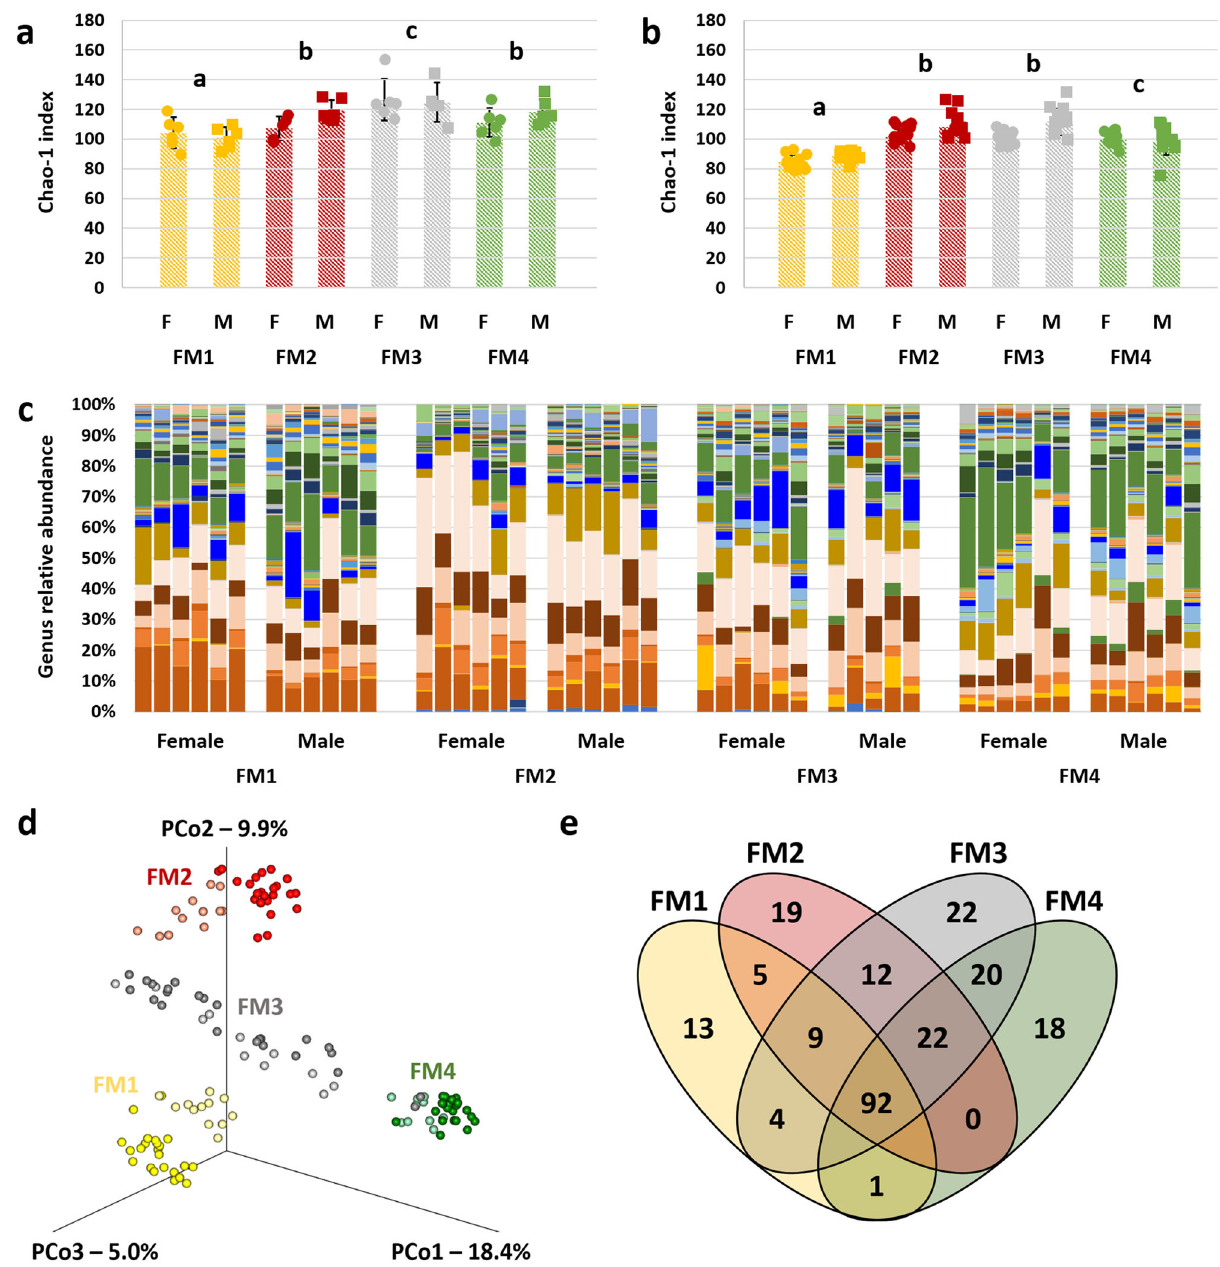
Fig. 1 Colonies of CD-1 mice are colonized with four distinct fecal microbiomes. a Dot plot showing the difference in microbial fecal richness ( p < 0.001, F = 10.1), as represented by the Chao-1 index, in 16-week-old, female (F) and male (M) CD-1 mice colonized with fecal microbiome 1 (FM1), FM2, FM3, or FM4 ( n = 5 – 6/sex/FM), and used in phenotyping tests. b Dot plot showing the difference in microbial fecal richness ( p < 0.001, F = 48.5), as represented by the Chao-1 index, in 6 to 12-week-old, female (F) and male (M) CD-1 mice colonized with FM1, FM2, FM3, or FM4 ( n = 12/sex/FM), collected from the parent colonies prior to shipping. c Stacked bar chart showing taxonomic diversity, at the level of genus, in female and male CD-1 mice ( n = 5-6/sex/FM) harboring one of four supplier-origin gut microbiomes (FM1 through FM4). d Three-dimensional principal coordinate analysis (PCoA) plot, based on Jaccard similarities, showing β -diversity captured by the fi rst three coordinates, of phenotyped mice (darker symbols, n = 5 – 6/sex/FM) and parent colonies (lighter symbols, n = 12/sex/FM). e Venn diagram showing the number of ASVs detected in at least one mouse of the various FM groups. p and F values represent the main effects of FM in two-way ANOVA, and post hoc comparisons via Holm – Sidak method; signi fi cant pairwise FM-dependent differences are denoted by different letters, underlying bar charts represent mean ±